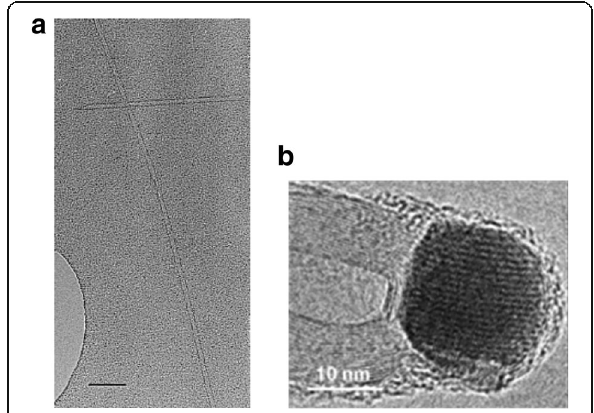
Fig. 8 TEM images of CNTs grown via CVD ( a ) an isolated SWCNT grown using Fe 2 O 3 catalyst with diameter of 5 nm. Scale bar equals 50 nm. Adapted from [102]. b MWCNTs grown with catalyst particle at tip end. Adapted from